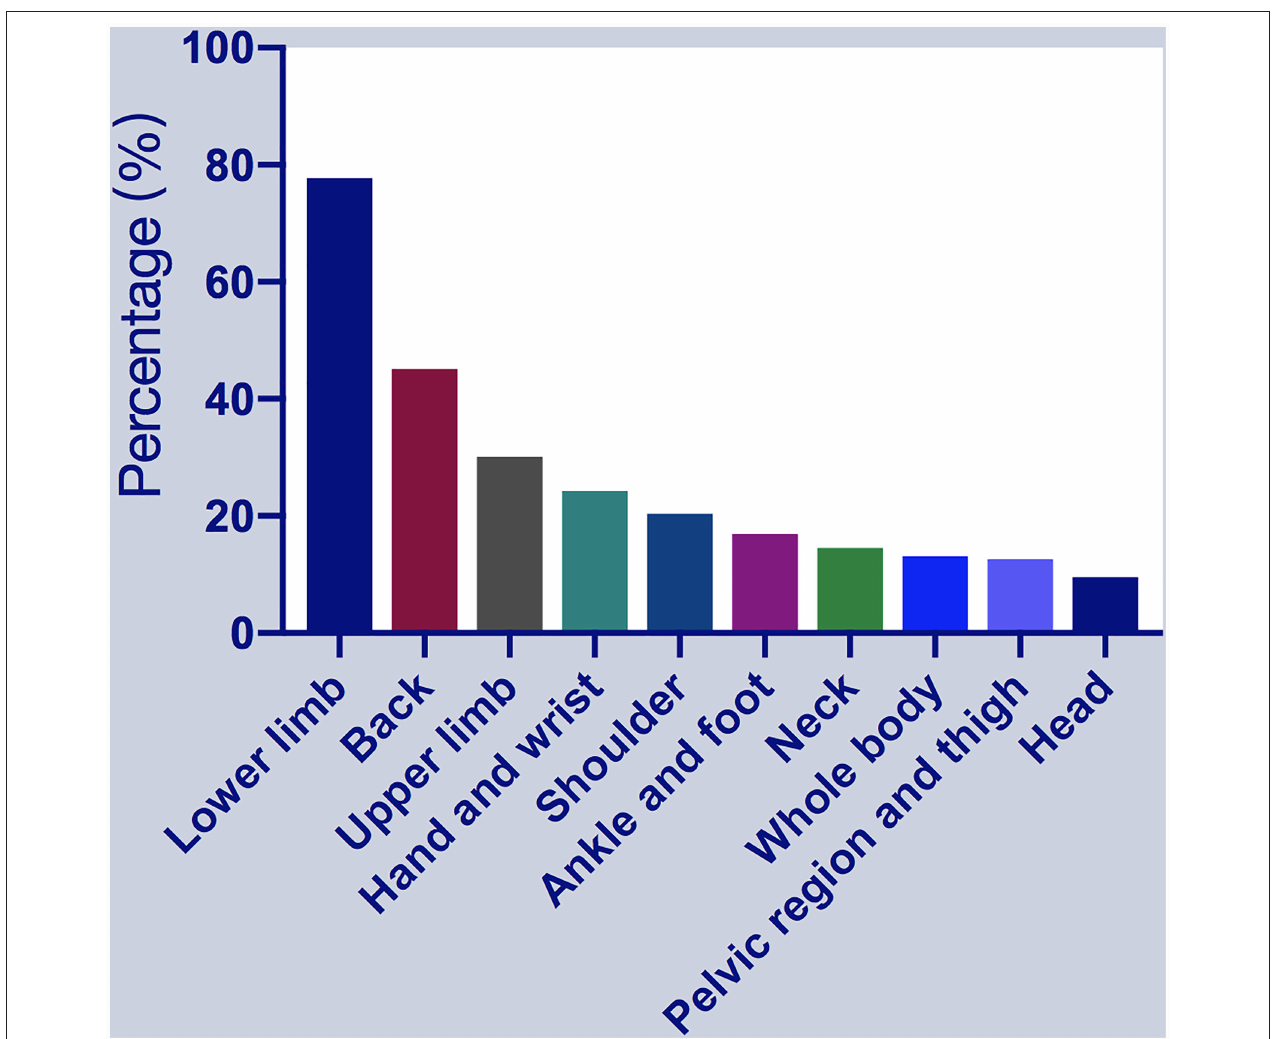
FIGURE 1 | Percentages of patients with musculoskeletal pain (MSP) who reported pain at specific locations. MSP, musculoskeletal